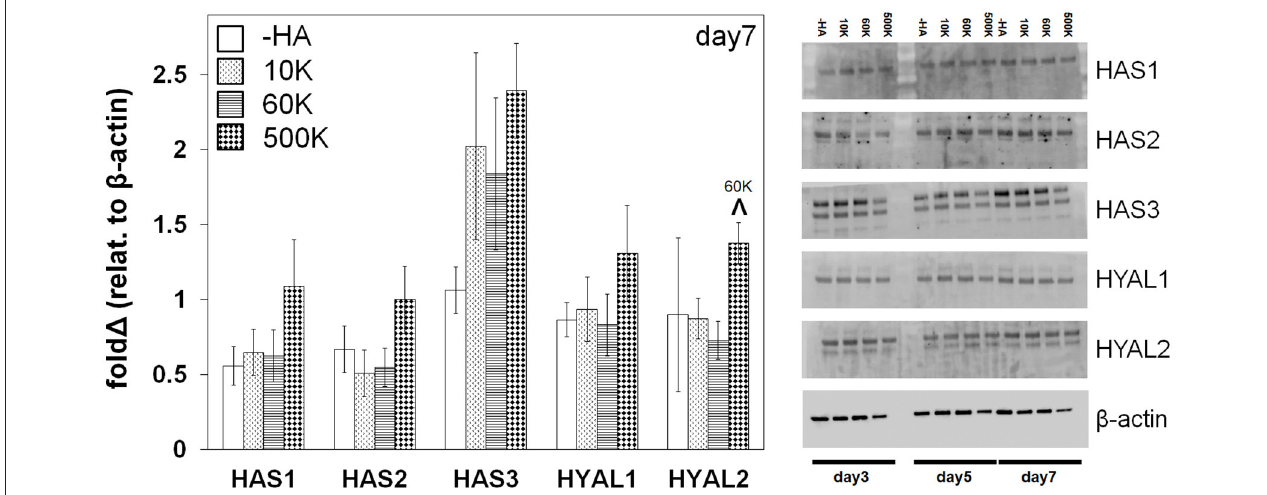
FIGURE 5 | Hyaluronan synthase (HAS) and hyaluronidase (HYAL) protein expression of GBM cells in gelatin hydrogels as a function of matrix immobilized HA molecular weight, analyzed via Western Blot at day 7 ( n